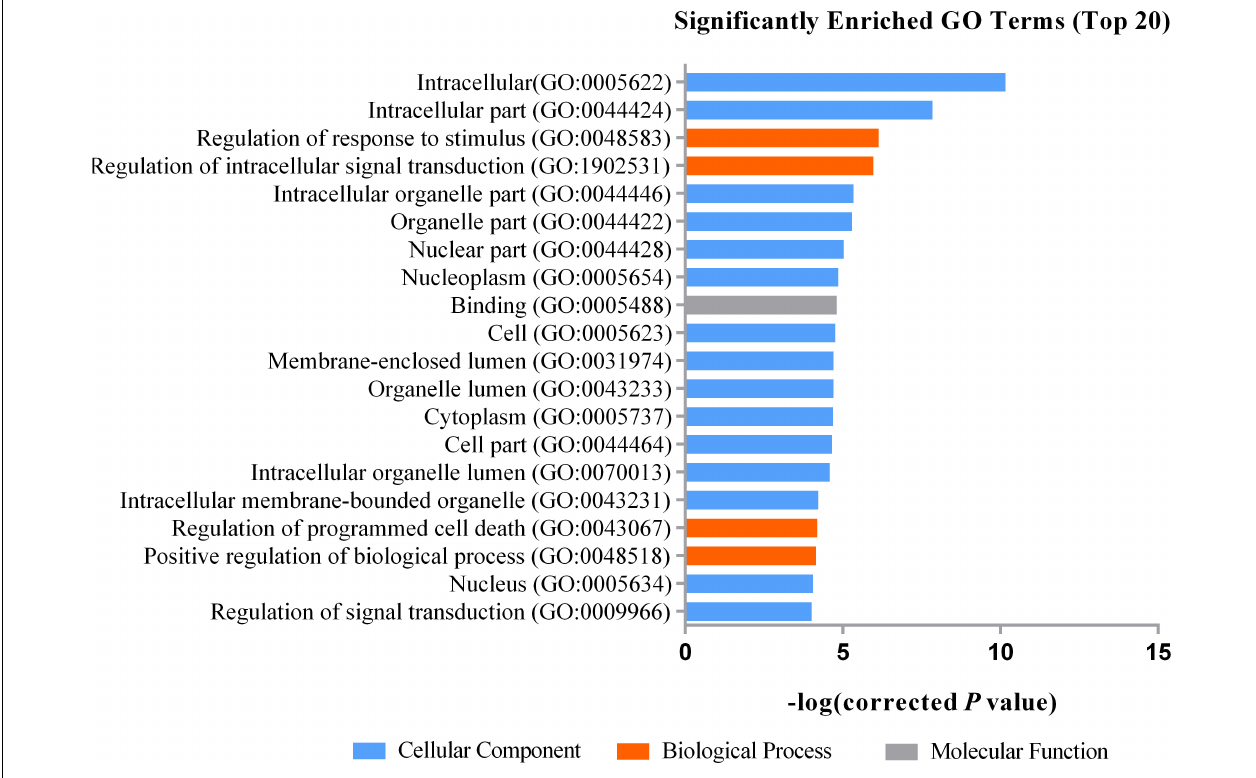
FIGURE 1 | The top 20 significantly enriched GO terms for DEGs. The top 20 GO items are Intracellular (GO:0005622), Intracellular part (GO:0044424), Regulation of response to stimulus (GO:0048583), Regulation of intracellular signal transduction (GO:1902531), Intracellular organelle part (GO:0044446), Organelle part (GO:0044422), Nuclear part (GO:0044428), Nucleoplasm (GO:0005654), Binding (GO:0005488), Cell (GO:0005623), Membrane-enclosed lumen (GO:0031974), Organelle lumen (GO:0043233), Cytoplasm (GO:0005737), Cell part (GO:0044464), Intracellular organelle lumen (GO:0070013), Intracellular